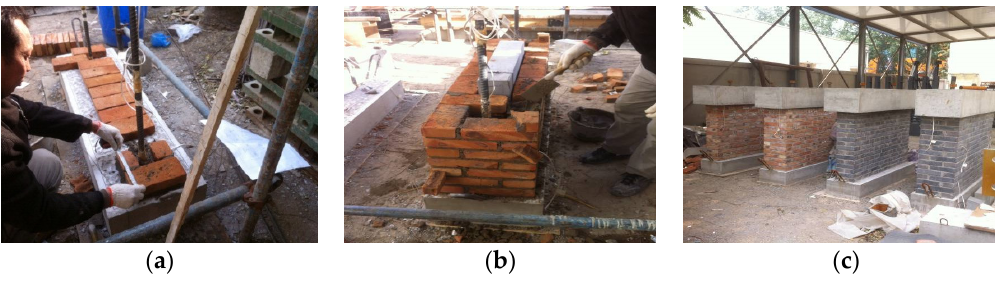
Figure 5. The making of the specimens: ( a ) stem making; ( b ) wall making; ( c ) completed specimen and its maintenance.